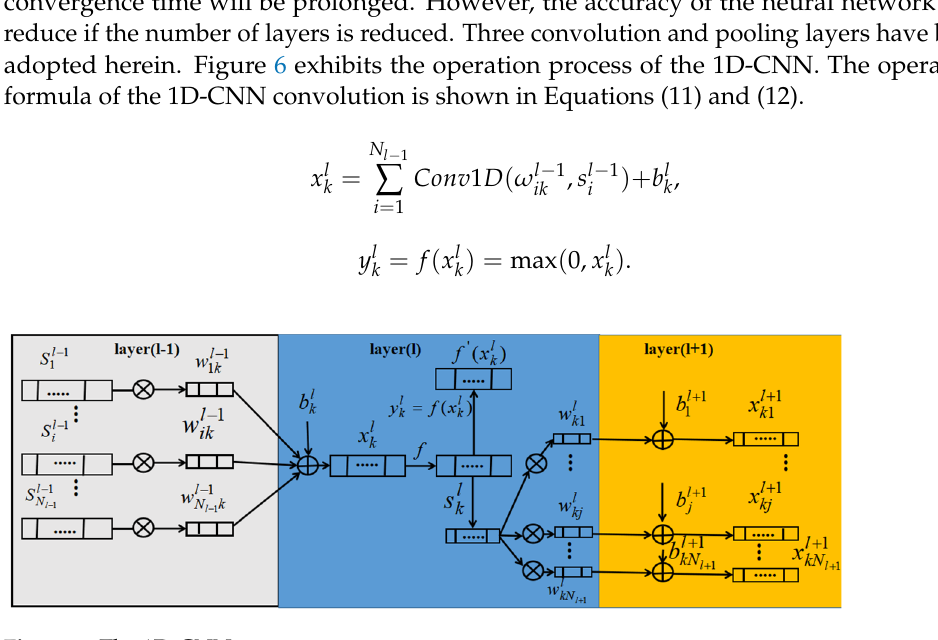
Figure 6. The 1D-CNN structure.